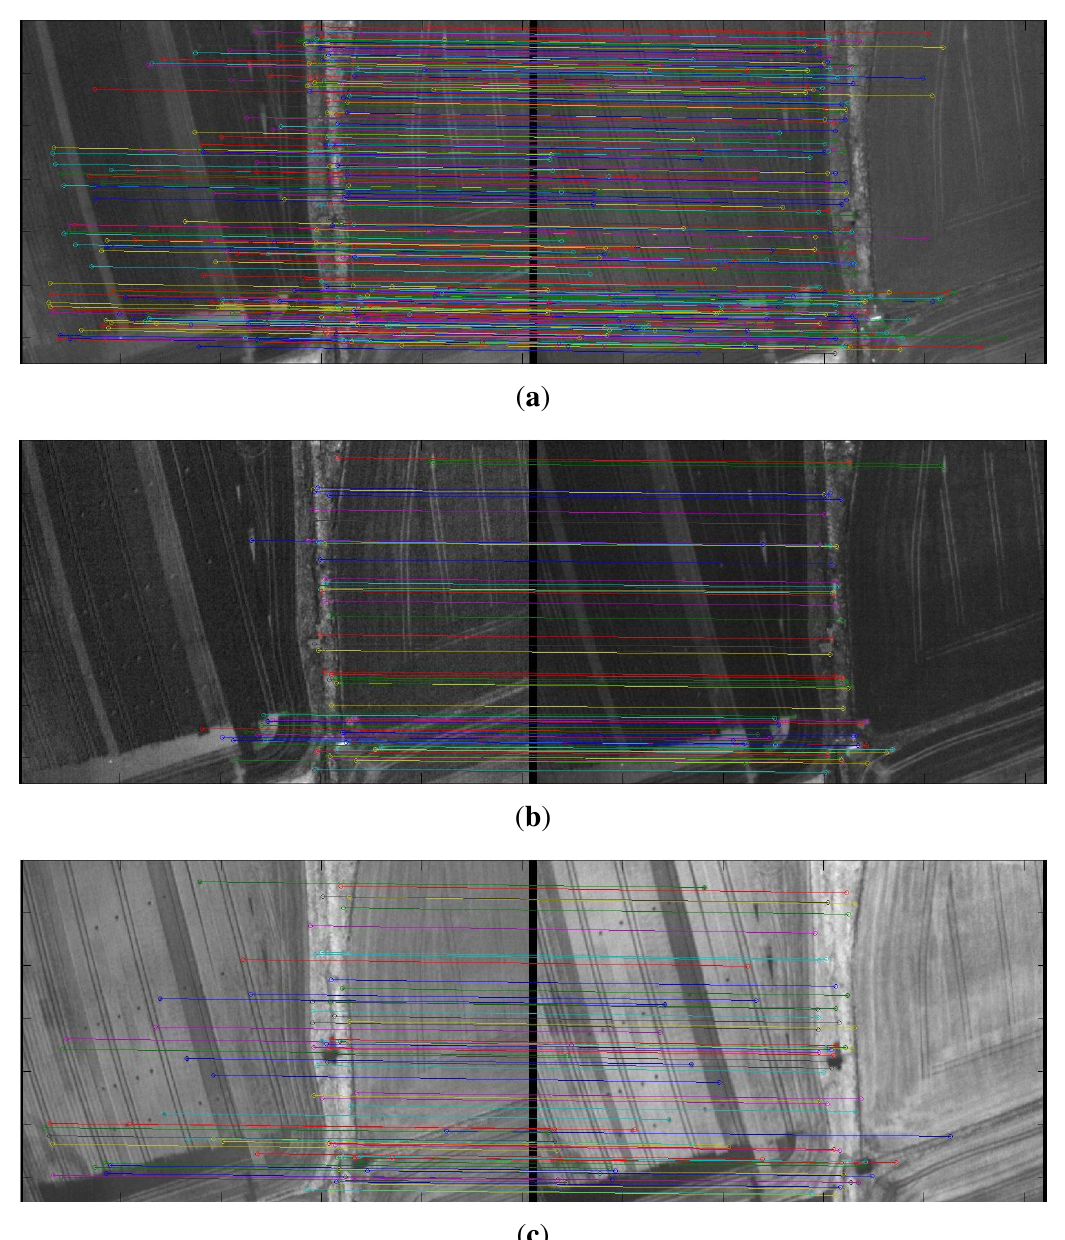
Band registration for every Main Spectral Group (MSG). The calculated registration errors (FRE) were relatively low i.e. , from 0.001 to 0.10. ( a ) Inliers (number of correspondences: 290) during the registration of the 1st spectral group. Bands: 510.2 nm (left) and 515.4 nm (right). ( b ) Inliers (number of correspondences: 72) during the registration of the 2nd spectral group. Bands: 601.7 nm (left) and 588.6 nm (right). ( c ) Inliers (number of correspondences: 75) during the registration of the 3rd spectral group. Bands: 783 nm (left) and 715 nm